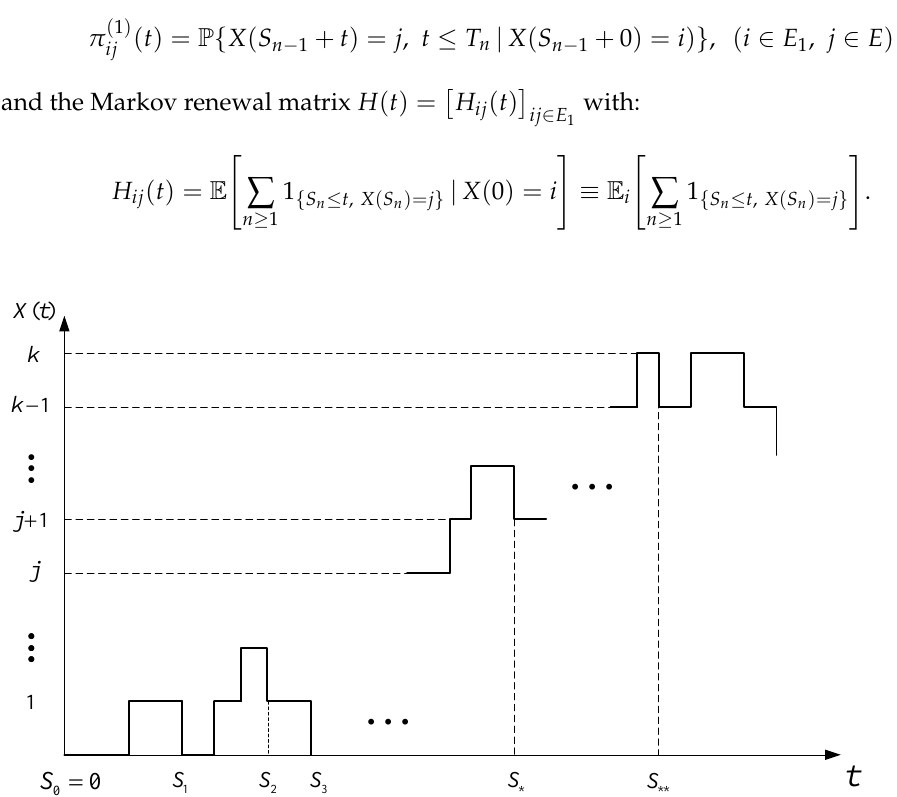
Figure 1. Trajectory of the process X for the system with partial repair, where S ∗ and S ∗∗ are arbitrary regeneration time